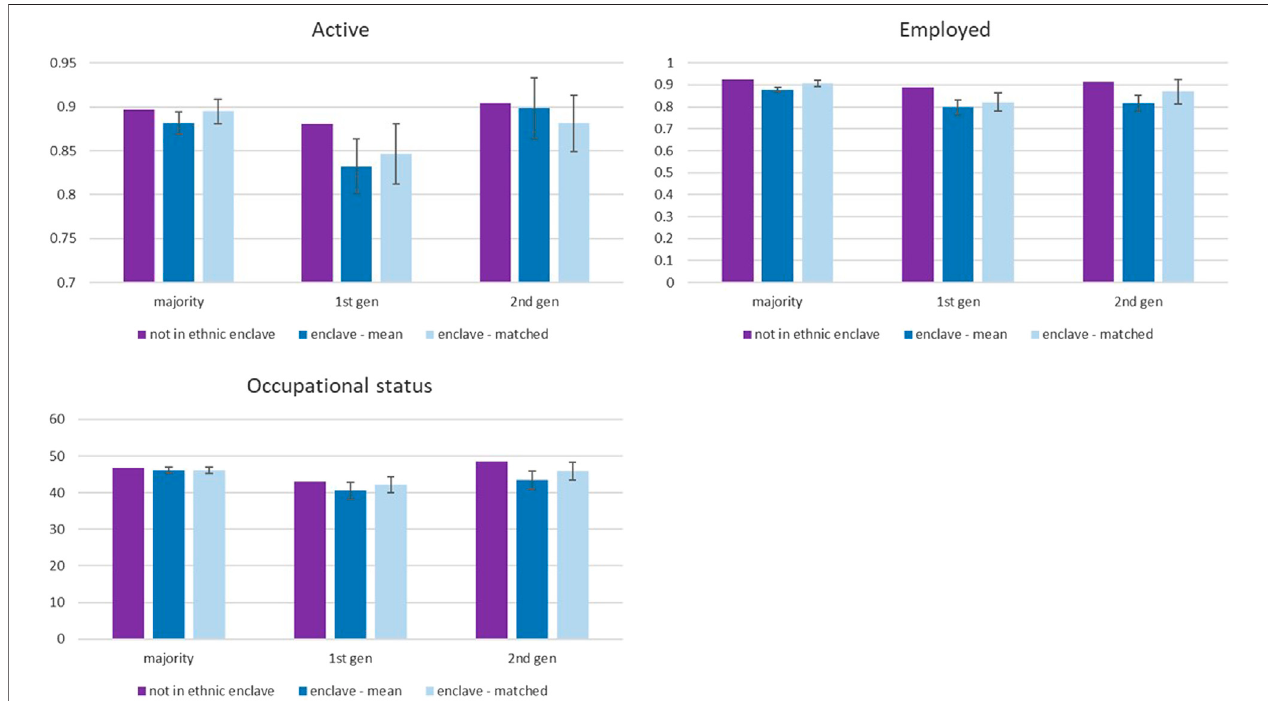
FIGURE 1 | Labor market status for inhabitants of an ethnic enclave and those living elsewhere — by migrant status. The mean difference is estimated through an independent samples t -test (two-tailed), and the matched difference shows the estimate after propensity score matching with fi ve nearest neighbors, taking individual sociodemographic factors into account. Outcome variables activity, employment, and occupational status are examined and the difference between enclave and non- enclave residents